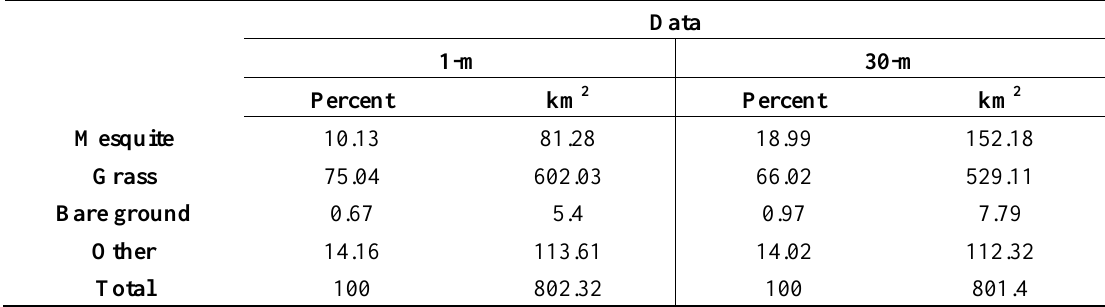
Table 1. Areas as measured from 1 and 30-m image classifications for mesquite, grass, bare ground, and other land cover classes at study site.